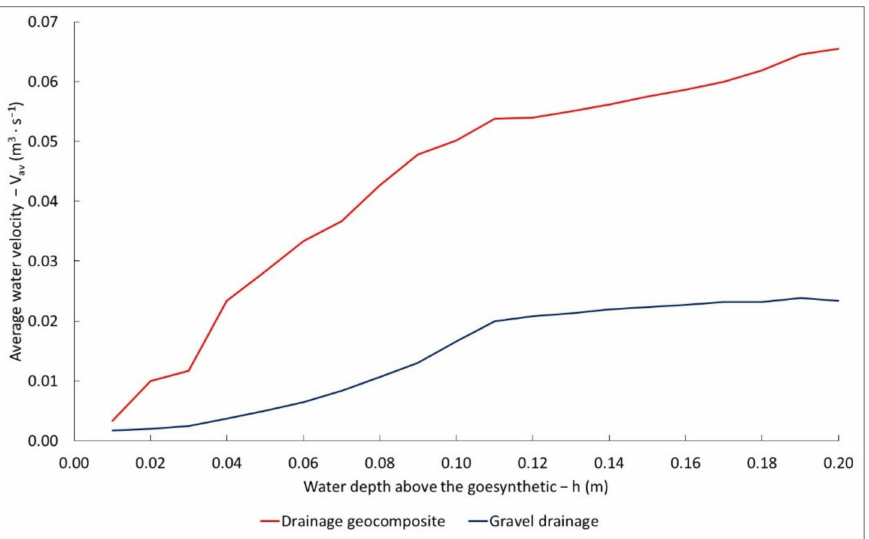
Figure 8. Water suction velocity of the geosynthetic drainage and gravel drainage for the entire